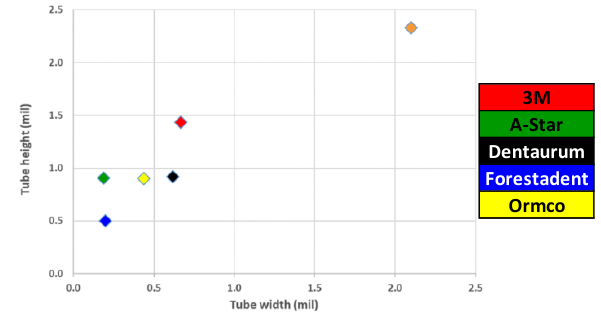
Figure 7: Mean difference between the molar tube front and back openings dimensions.